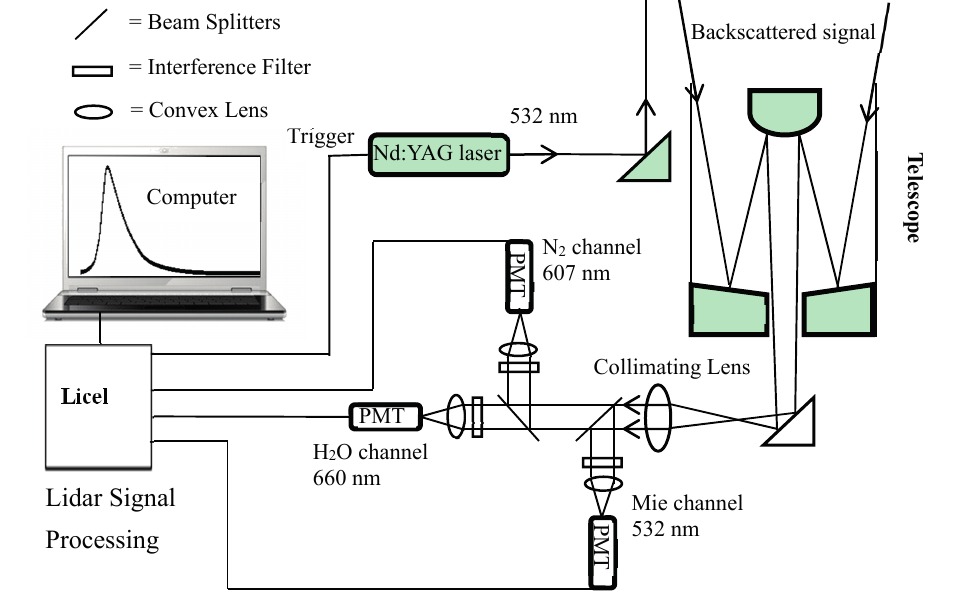
Figure 2. Schematic of the Raman Lidar (RL)